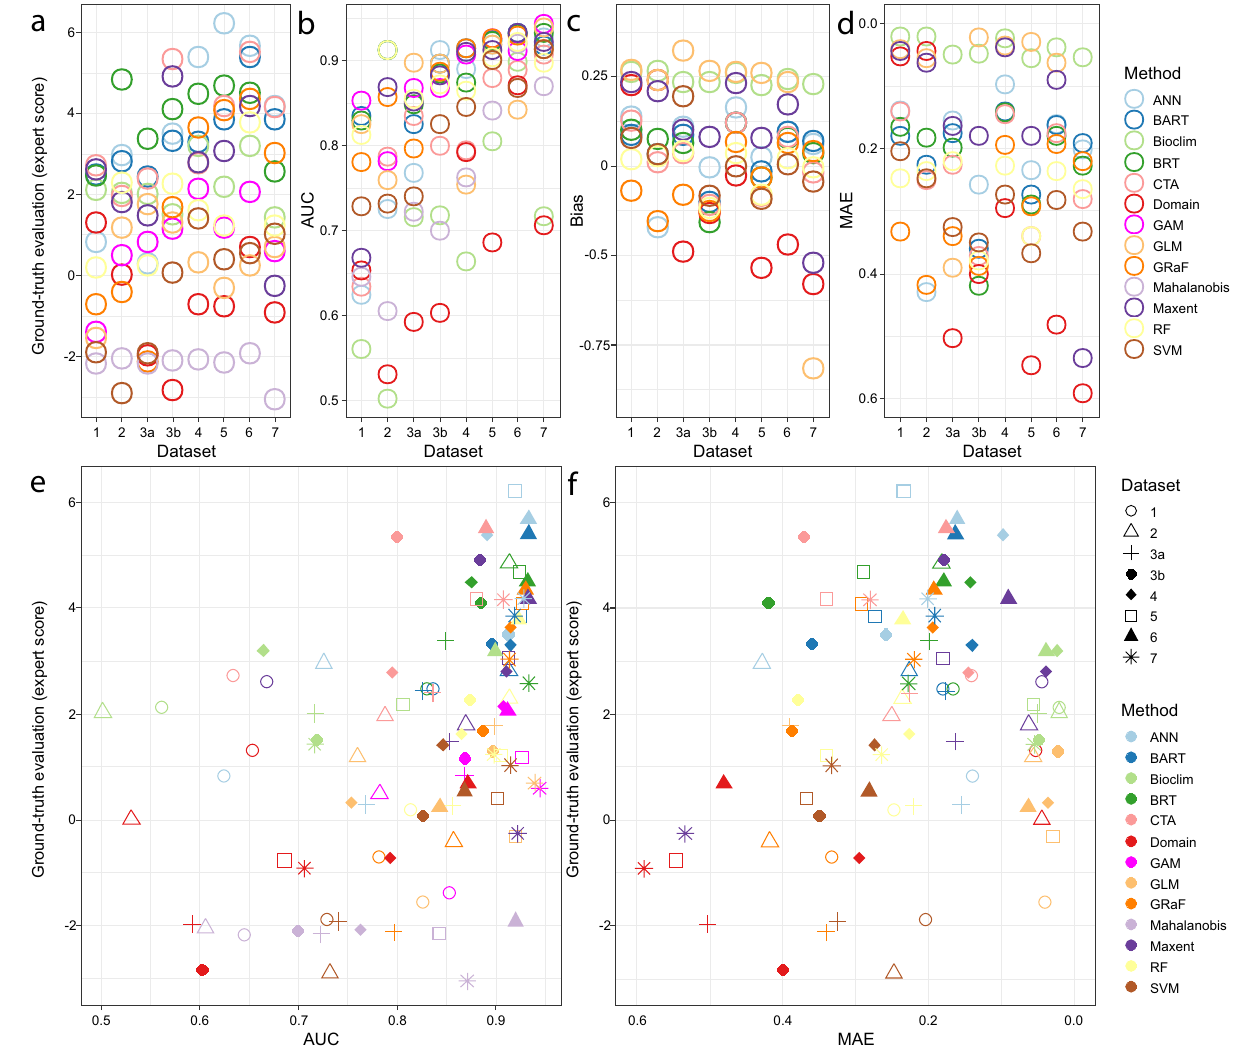
Figure 3. Plots representing different datasets, algorithms, and their evaluation metrics: ( a ) ground-truth evaluation (expert score), ( b ) AUC, ( c ) bias, ( d ) MAE, ( e ) relation between ground-truth evaluation and AUC, ( f ) relation between ground-truth evaluation and MAE. Numbers referring to datasets correspond to those in Fig. 1: 1—Gorce Mts 30 , 2—Bieszczady Mts 31 , 3a—Atpol quadrats 32 , 3b—centroids of Atpol quadrats, 4—Slovakian occurrences 26 , 5—Carpathian Mts occurrences 26 , 6—georeferenced herbarium material, 7— distribution in the Carpathians 33 . Note that the y-axis scale for ( d ) and the x-axis scale for ( f ) are inverted for ease of comparison with other